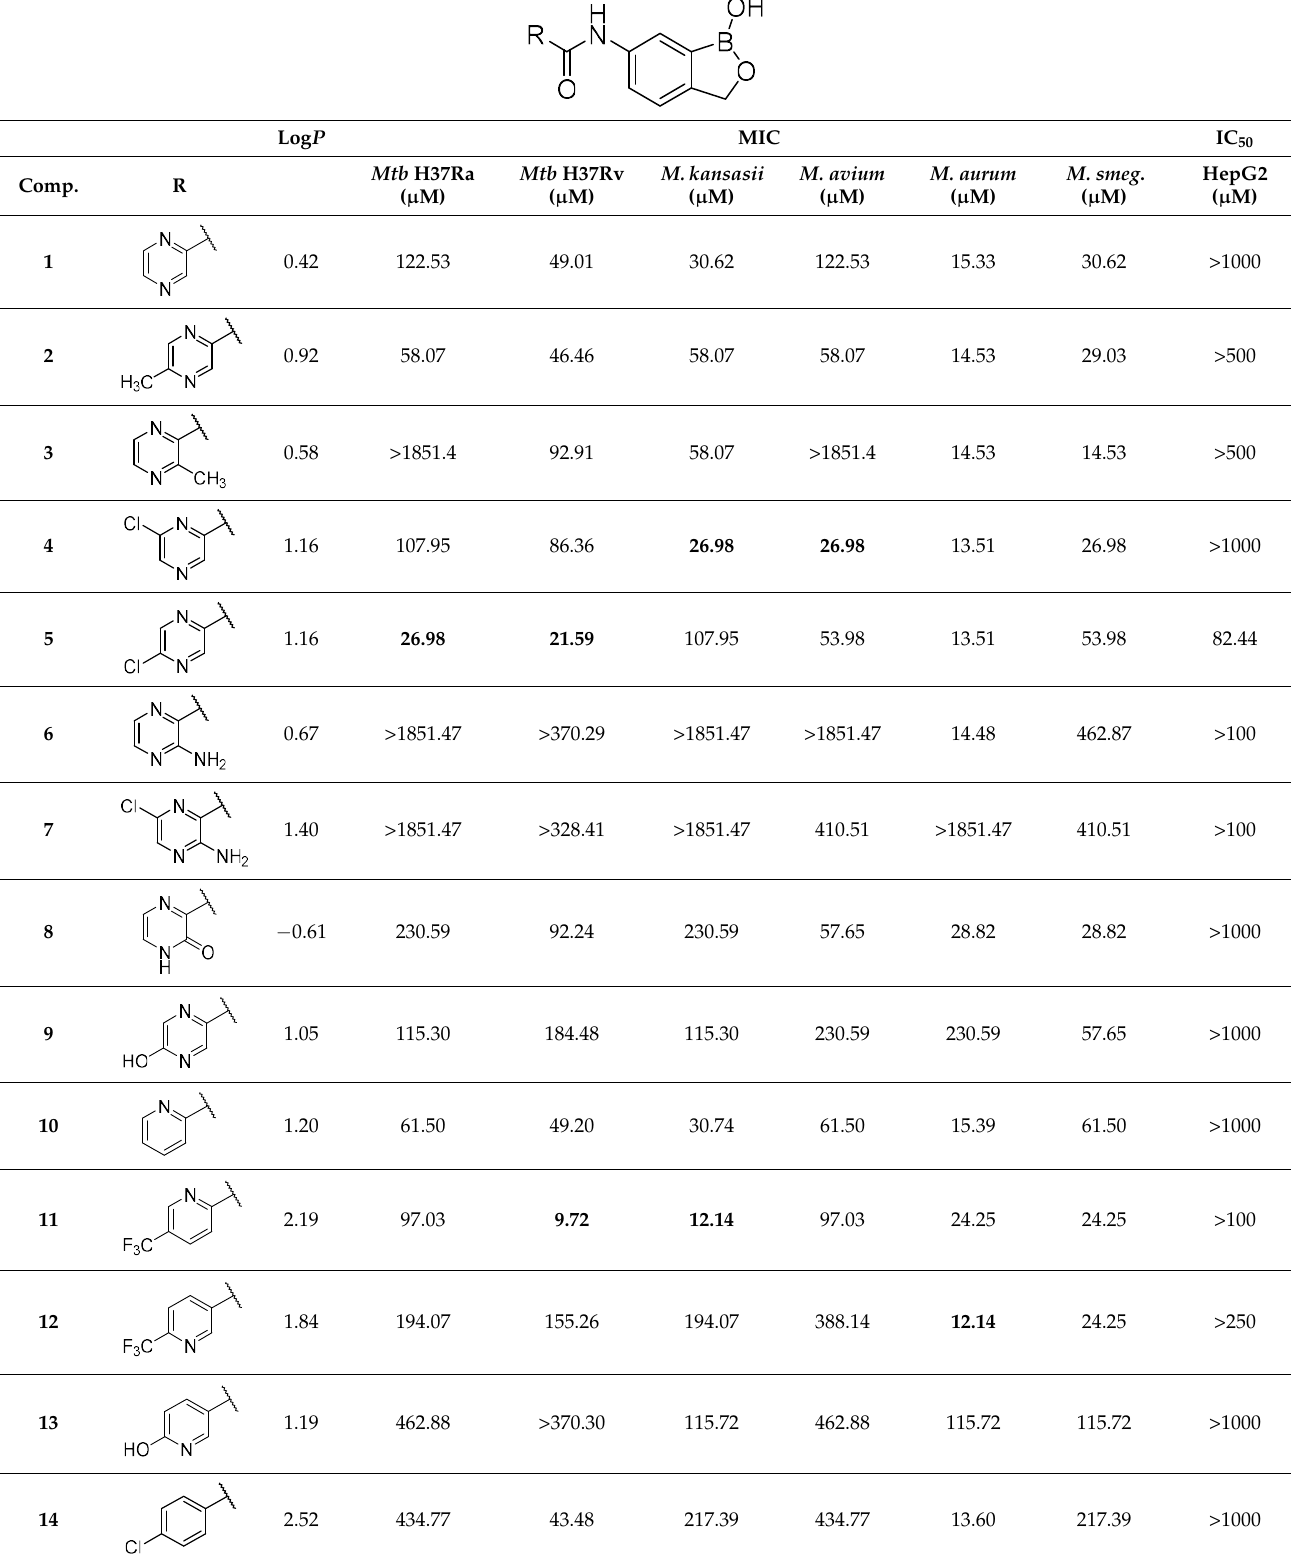
Table 1 . Calculated lipophilicity of the prepared compounds (log P ), comparison of their antimycobacterial activity (MIC) with standards, and their cytotoxicity against HepG2 (IC 50 ).